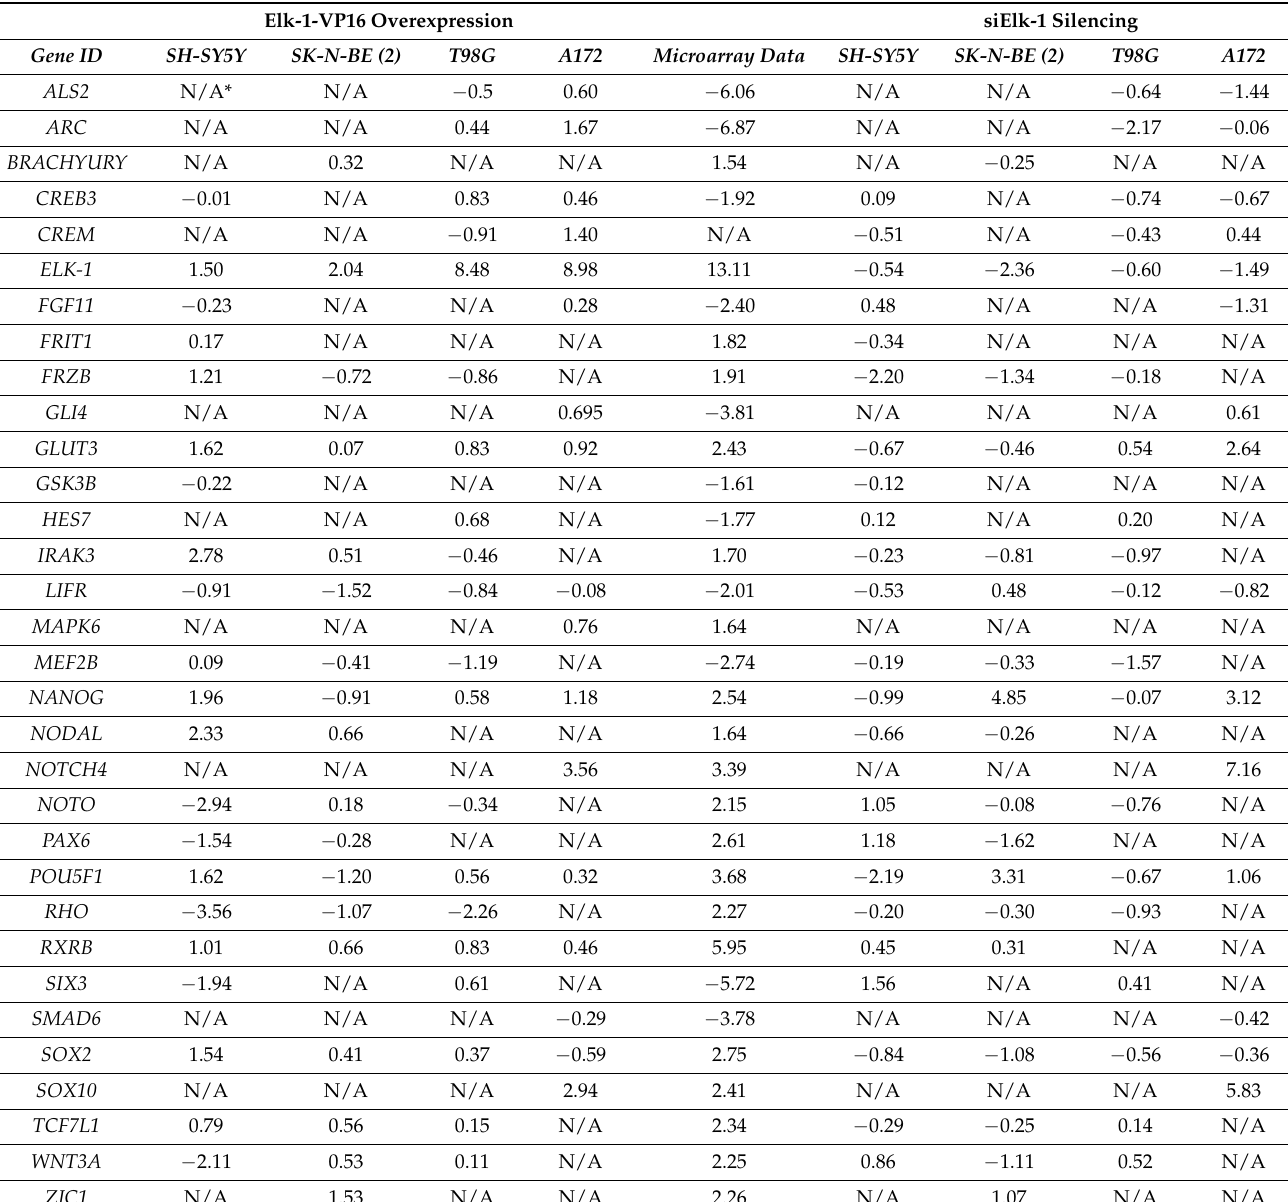
Table 6. Summary of qPCR and microarray comparisons of selected potential Elk-1 target genes after Elk1-VP16 over- expression or siElk-1 silencing in neuroblastoma and glioblastoma cell